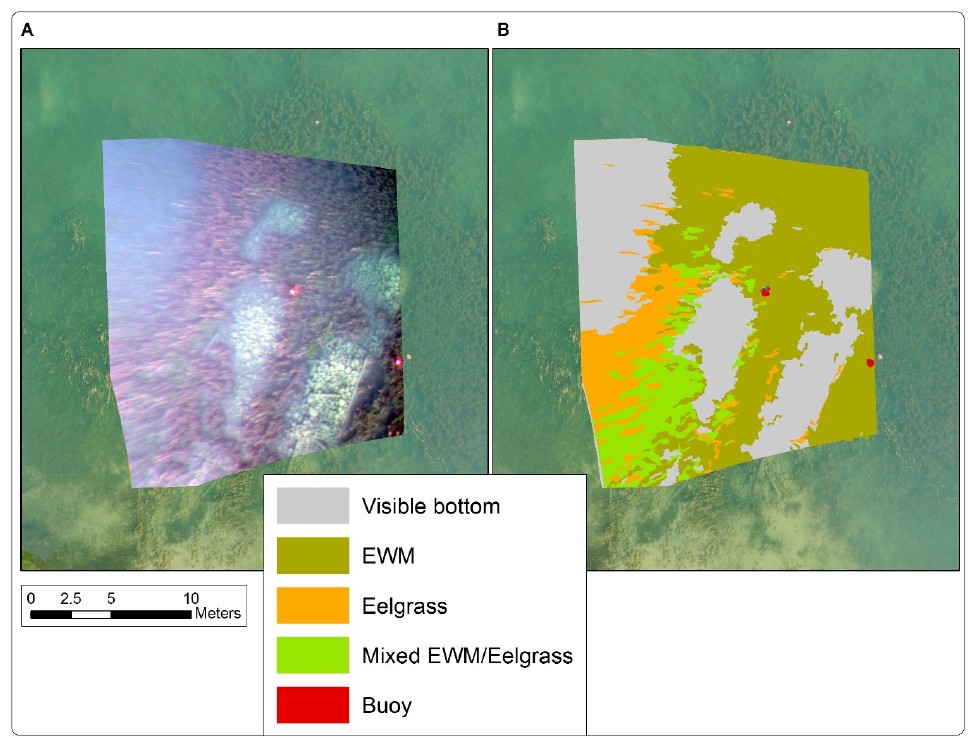
Figure 8. Howells Dock, image 916, July 2017 example result, with ( A ) Tetracam imagery and ( B ) classification result with scale parameter = 25.